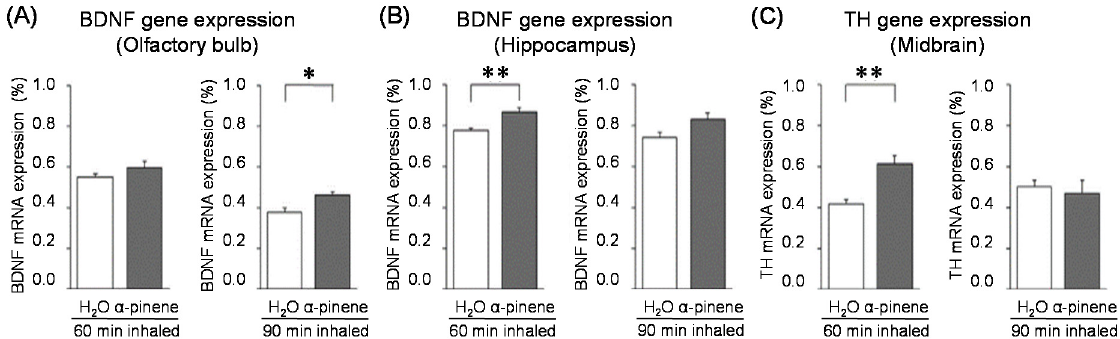
Figure 6. Effects of α -pinene on gene expression levels in the brain. After inhaling distilled water or α -pinene into stressed mice, the olfactory bulb, hippocampus, and midbrain were used for RT-PCR analysis. ( A ): Expression of BDNF gene in the olfactory bulb. ( B ): Expression of BDNF gene in the hippocampus. ( C ): Expression of tyrosine hydroxylase (TH) gene in the midbrain. The results are expressed as the ratio of the mRNA expression level of BDNF or TH to that of GAPDH (%) and are means ± SEM (n = 5). * p < 0.05, ** p < 0.01 (Student’s t -test). This figure is modified based on the original figure [103] with the copyright permission.